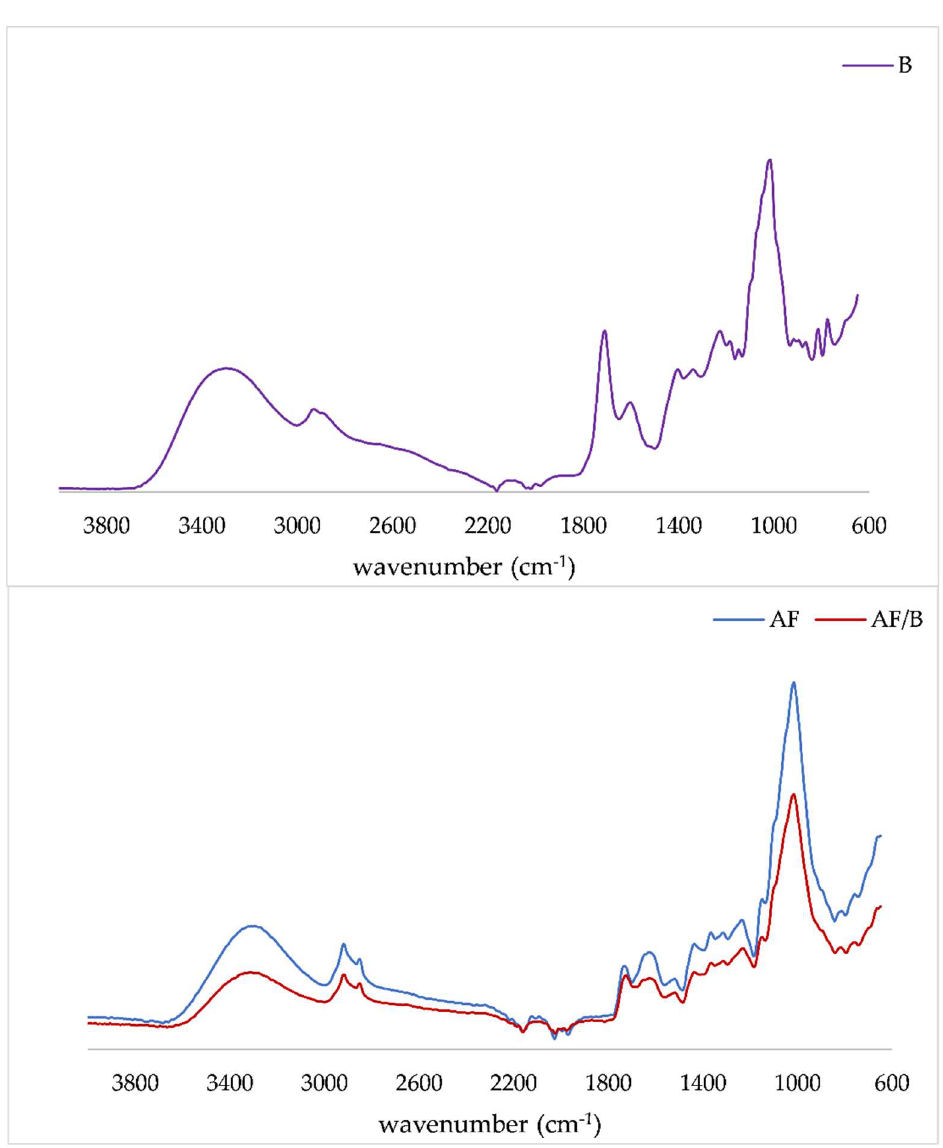
Figure 3. IR spectra of blackberry juice (B), apple fiber (AF) and apple fiber/blackberry juice complex (AF/B).